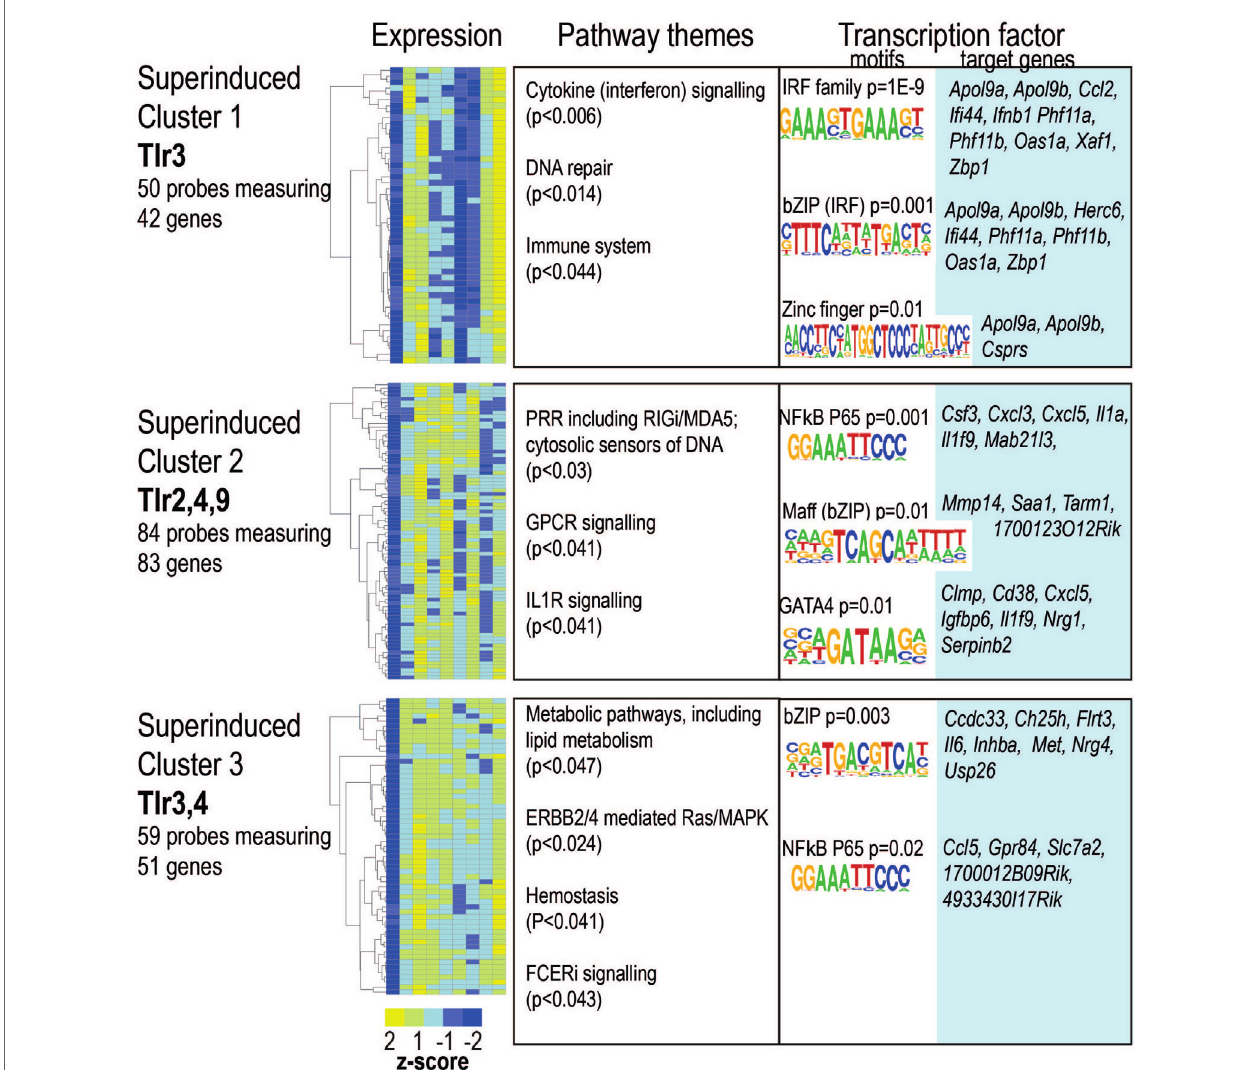
FigUre 6 | Ligand-specific patterns of super-induction on toll-like receptor (TLR) re-stimulation. Probes showing super-induction in at least one infection were clustered using partitioning around medoids. Heat maps for each cluster. Color indicates row z -score of mean log 2 expression. Columns (L–R) naïve, lipopolysaccharide acute, and restimulation; CpG acute, restimulation; Pam3csk4 acute, restimulation; Poly(I:C) acute, restimulation. Pearson correlation of z scores shown in rows. Significantly enriched pathways, grouped thematically. Maximum adjusted p -value for all pathways significantly enriched in that theme is shown. Transcription factor binding motifs enriched in each cluster. Motif logos and p -values are representative for each transcription factor family. Full motif enrichment results are available at